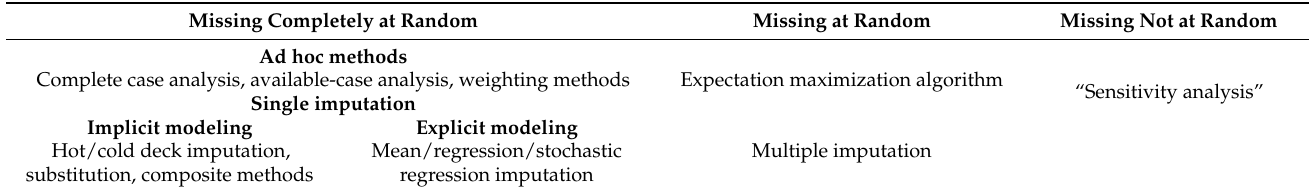
Table 1. Imputation methods by type of missing